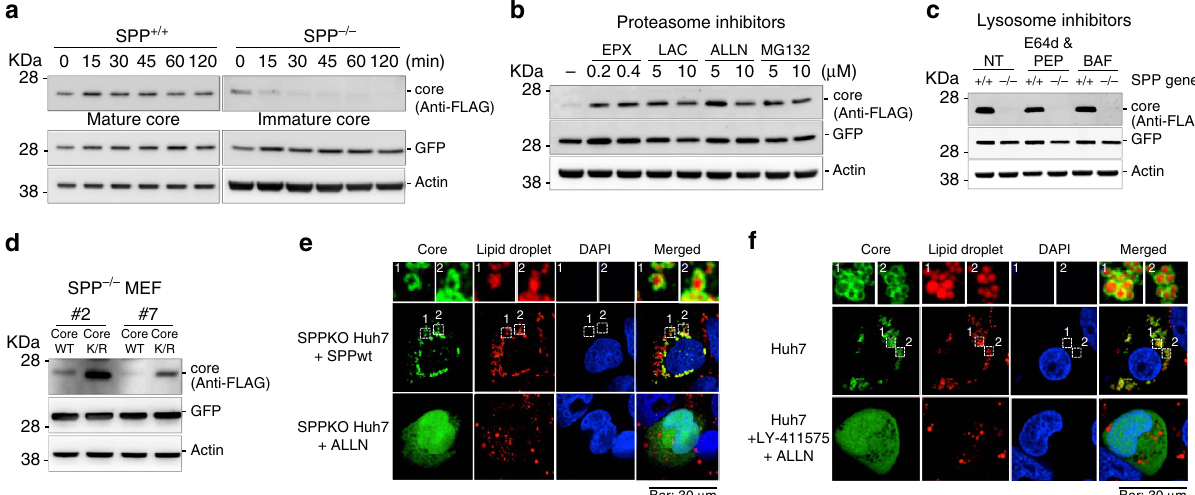
Figure 2 | Ubiquitin-proteasomal degradation of the immature HCV core protein in SPPKO cells. ( a ) SPP þ / þ MEFs and SPP (cid:2) / (cid:2) MEFs infected with a lentivirus expressing FLAG-core were treated with cycloheximide (100 m M) at 48h post infection and were subjected to immunoblotting at the